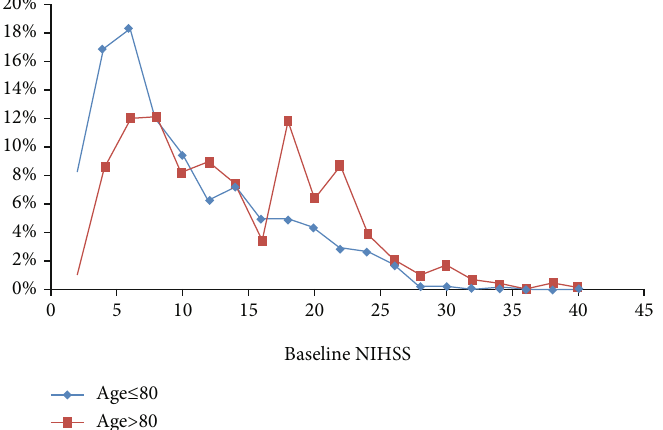
Figure 1: The comparison of proportions of patients in all stroke severity in two age groups. NIHSS: National Institutes of Health Stroke Scale. The area under each curve adds up to